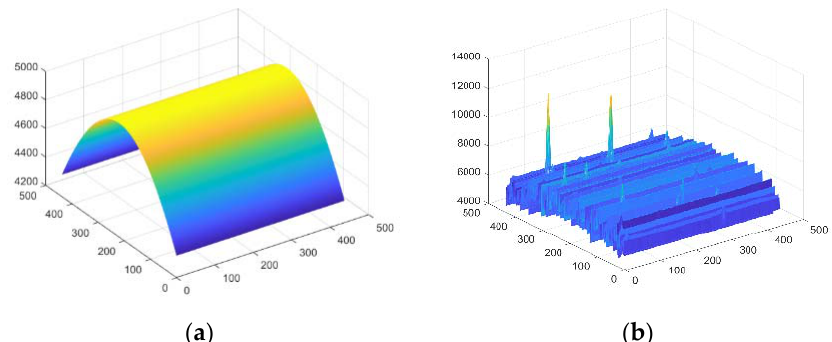
Figure 5. Data obtained by a scanning infrared focal plane array with a steady ‐ mode internal calibration source output (ICS equivalent output: 5000): ( a ) steady ‐ mode ICS radiance distribution when the ICS equivalent radiance output is 5000; ( b ) actual space scene data superposed with a steady ‐ mode ICS output and various influential factors.